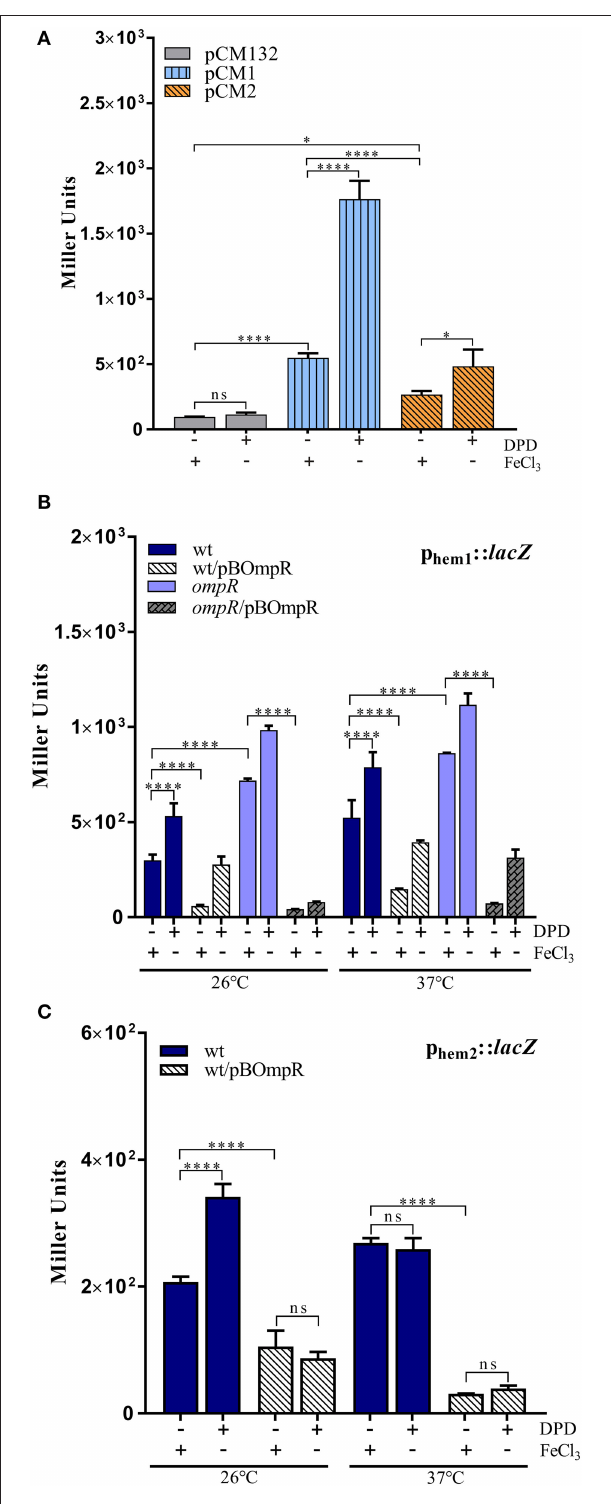
FIGURE 5 | OmpR-dependent regulation of hem -1 and hem -2 operon expression. (A ) Activity of the p hem − 1 and p hem − 2 promoters in E. coli BW25113 harboring the p hem − 1 :: lacZ (pCM1) or p hem − 2 :: lacZ (pCM2) fusion